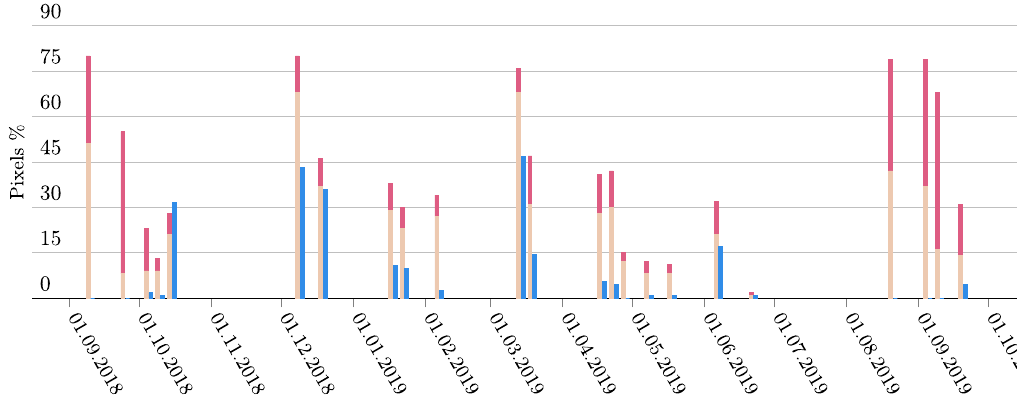
Figure 9. Percentages of pixels identified as cloud and cloud shadows by our classifier and as clouds by the Sen2Cor algorithm.